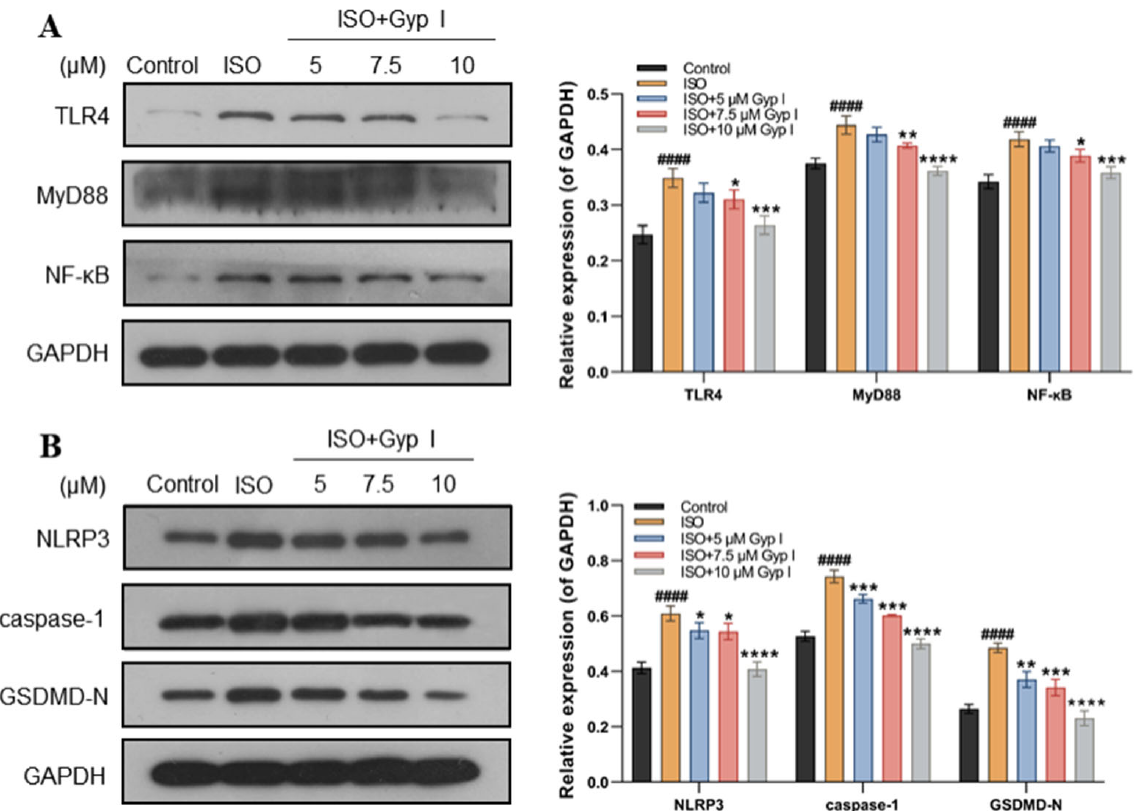
Figure 4. Effect of Gyp I on the expression of the TLR4/NF- κ B/NLRP3 signaling pathway in vitro: ( A ) The relative expression of TLR4, MyD88, and NF- κ B. ( B ) The relative expression of NLRP3, caspase-1, and GSDMD-N. Results are presented as mean ± SD of three independent experiments using one ‐ way ANOVA followed by Tukey’s multiple ‐ comparison test (####: p < 0.0001 compared with Control group; *: p < 0.05, **: p < 0.01, ***: p < 0.001, ****: p < 0.0001 compared with ISO group).